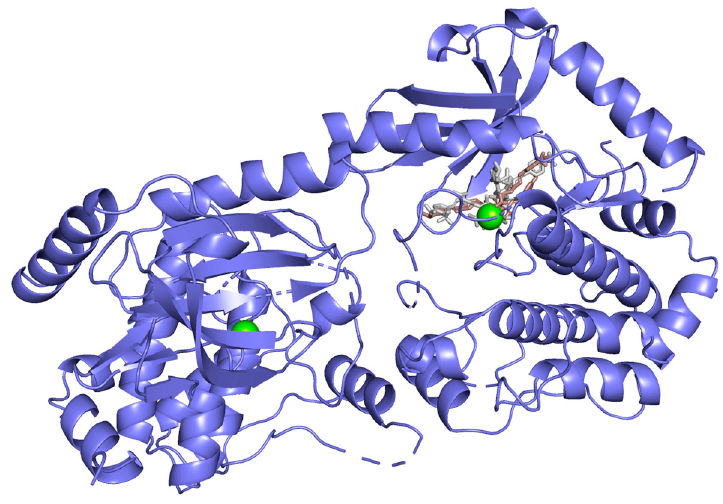
Figure 10. MEK-1 kinase (PDB ID: 3SLS) in complex with vanicoside A (gray) and B (pink).